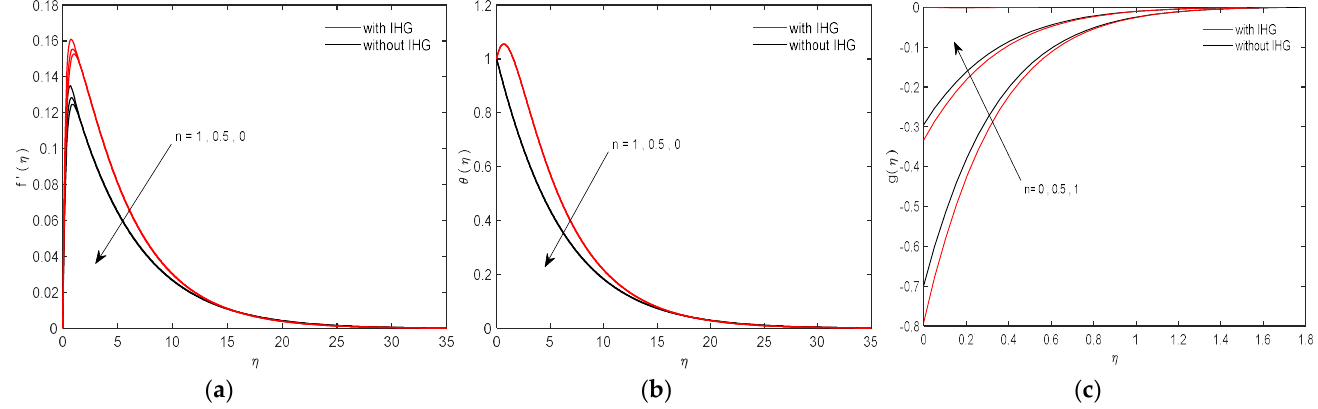
Figure 7. The effect of the micro-rotation parameter n on the ( a ) velocity profile, ( b ) temperature profile and ( c ) angular velocity profile for R = 0.5, M = 2, λ = 0.5, c = 0, B = 0.2, Φ 1 = φ 2 = 0.05, Da = 1, Rd = 1, f w = 0.5.